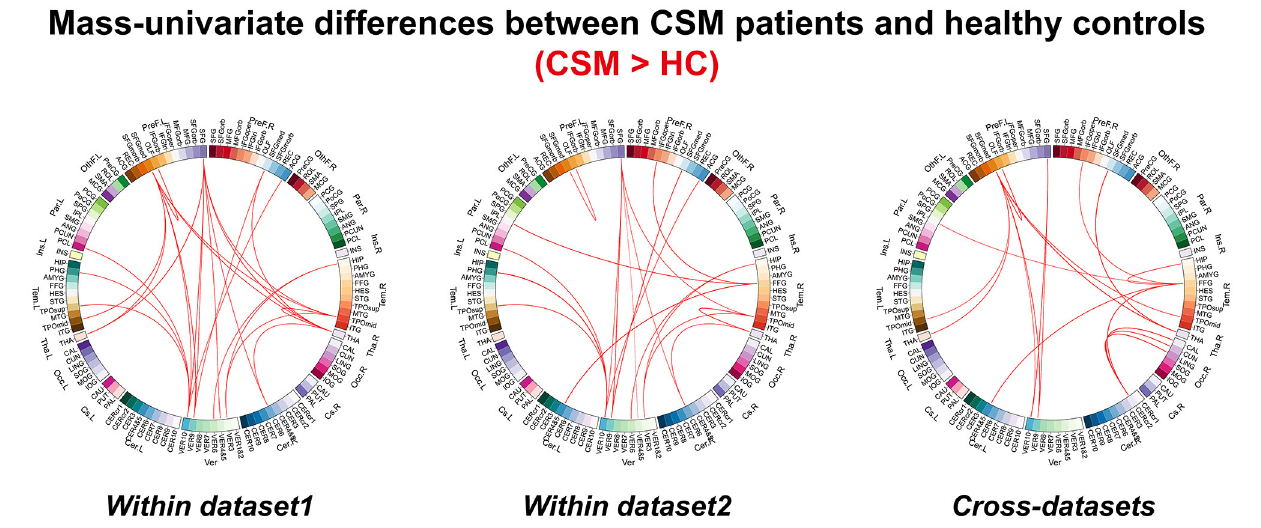
FIGURE 2 | The differences for functional connectivity between cervical spondylotic myelopathy patients and healthy controls revealed by mass univariate